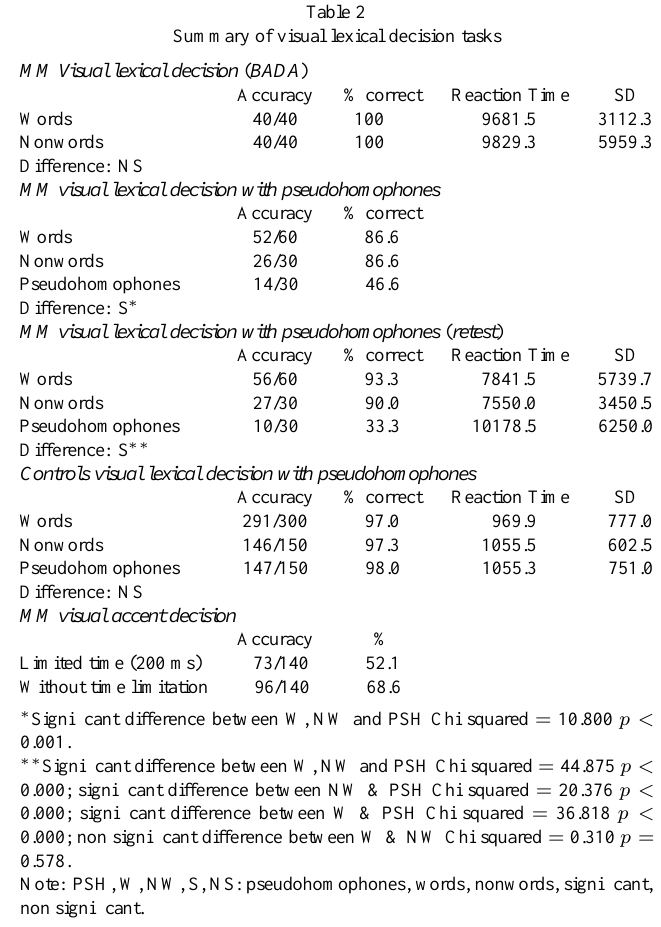
Table 2 Summary of visual lexical decision